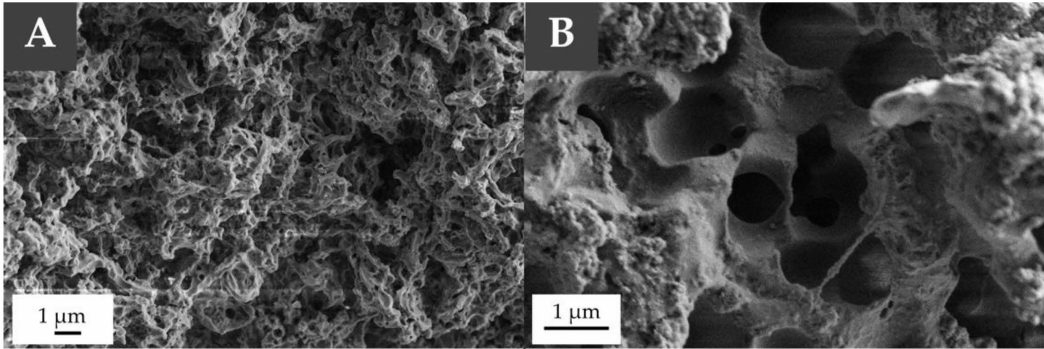
Figure 4. SEM pictures of a representative freeze-dried I-Series (I2) polyHIPE: ( A ) I2 (5K × ); ( B ) I2 10K ×